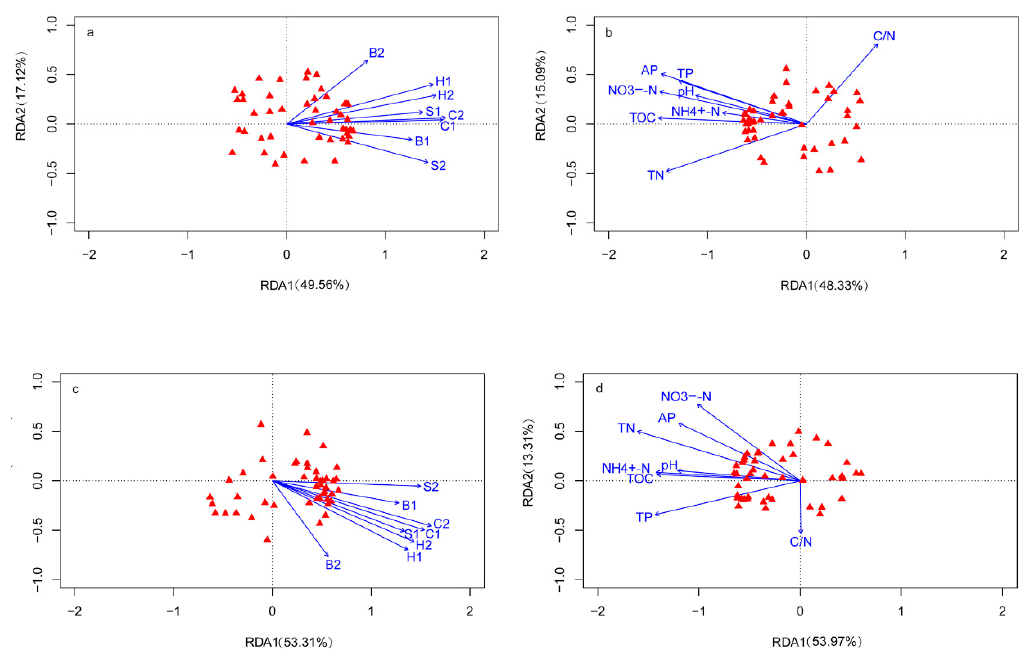
Figure 2. Redundancy analysis on the relationship betweenthe undergrowth vegetation, soil properties, and microbial communities in organic layer ( a , b ) and mineral layer ( c , d ). The solid red triangle presents for individual phospholipid fatty acids (PLFA), determined in sites. S1: shrub richness; S2: herb richness; H1: shrub H plant ; H2: herb H plant ; C1: shrub coverage; C2: herb coverage; B1: shrub biomass; B2: herb biomass; TOC: total organic carbon; TN: total nitrogen; TP: total phosphorus; AP: available phosphorus; C/N: organic carbon to total nitrogen ratio.